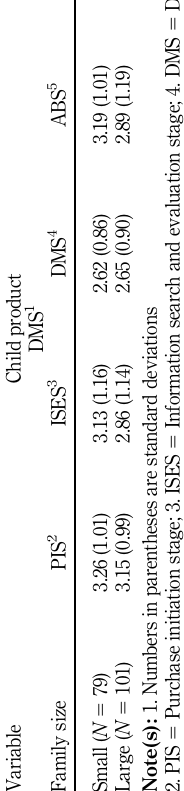
Table 6. Mean scores of children ’ s influence in DMS in Indianfamilies: family